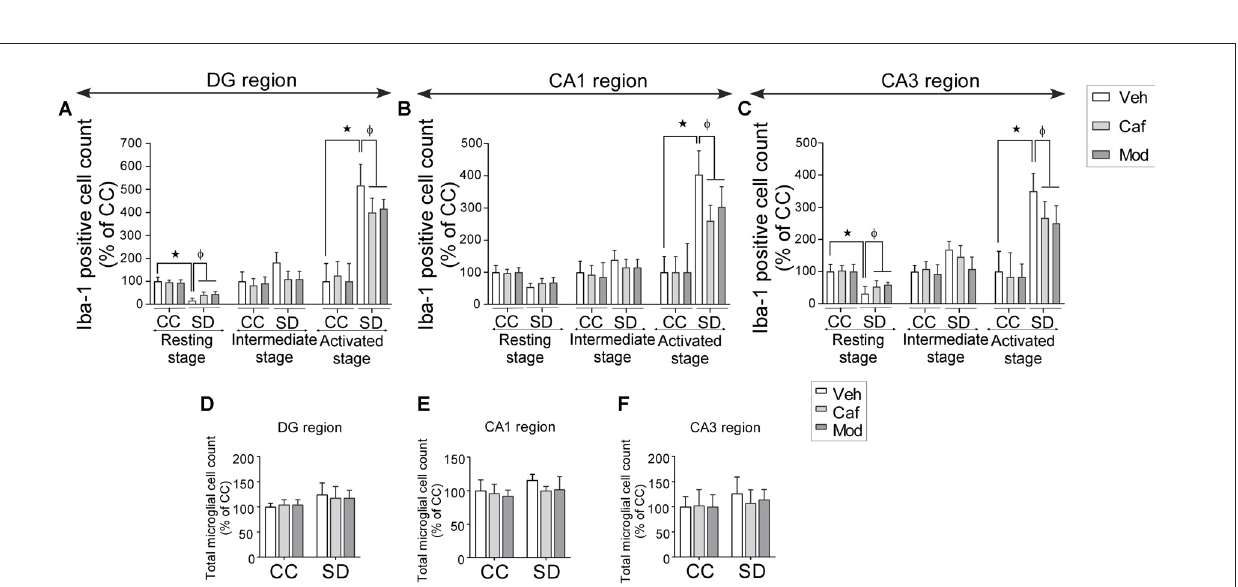
F ( dFn,dFd ) ; p < 0.0001